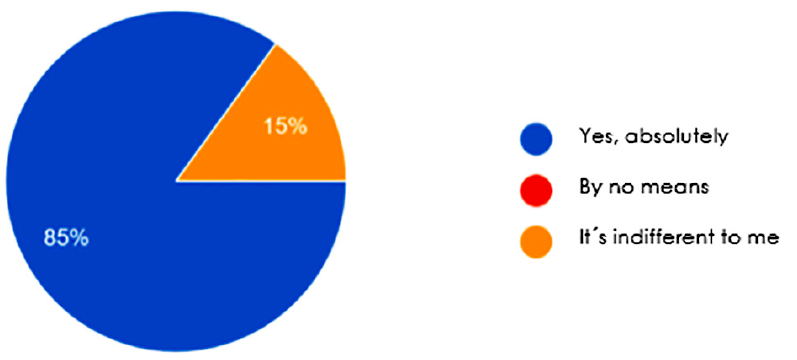
Figure 17. Students interest in math approaches such as these.